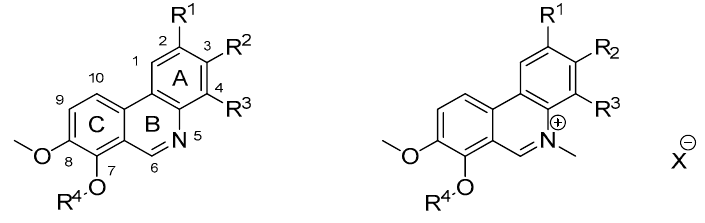
Figure 2. Desired phenanthridines for biological evaluation (for details see Table 1).